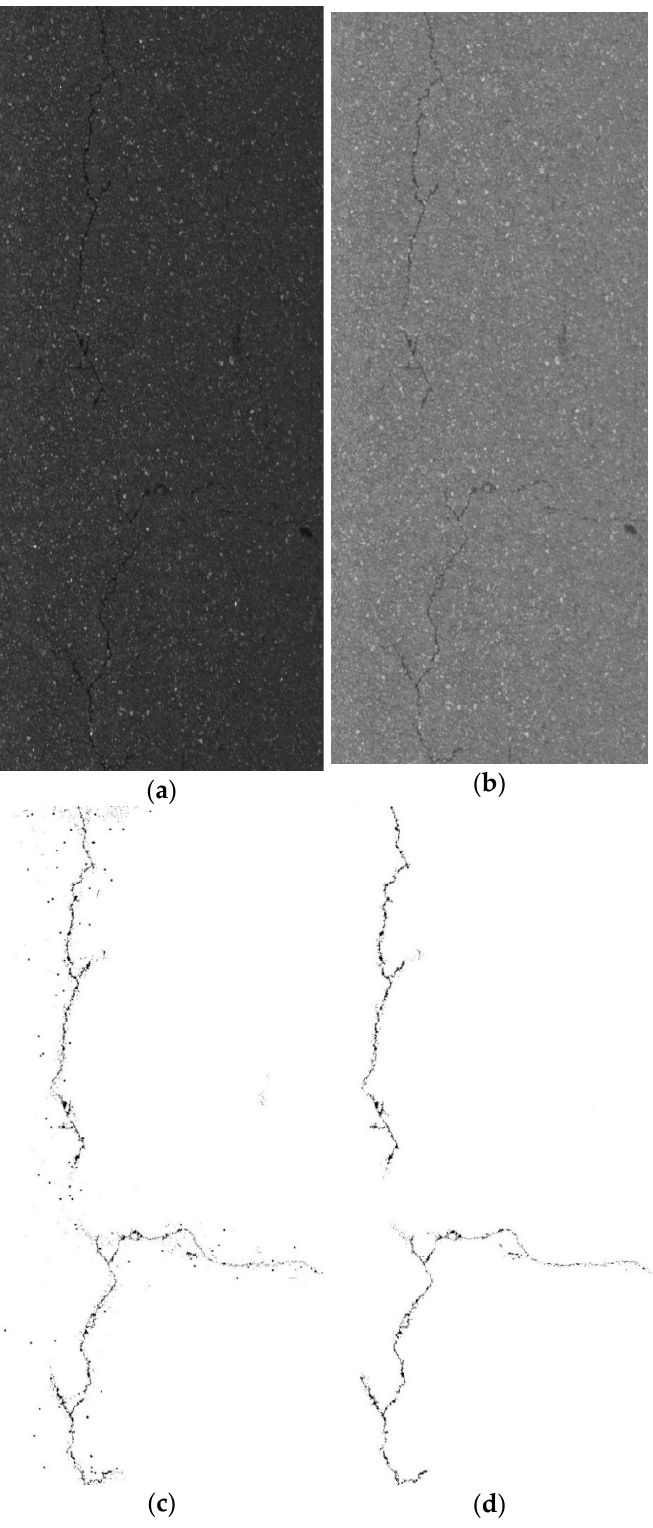
Figure 22. Comparative experiment of transverse crack segmentation . ( a ) original images, ( b ) im- age enhanced by guided filtering and Retinex method, ( c ) images generated by traditional k- means clustering algorithm, ( d ) ours.